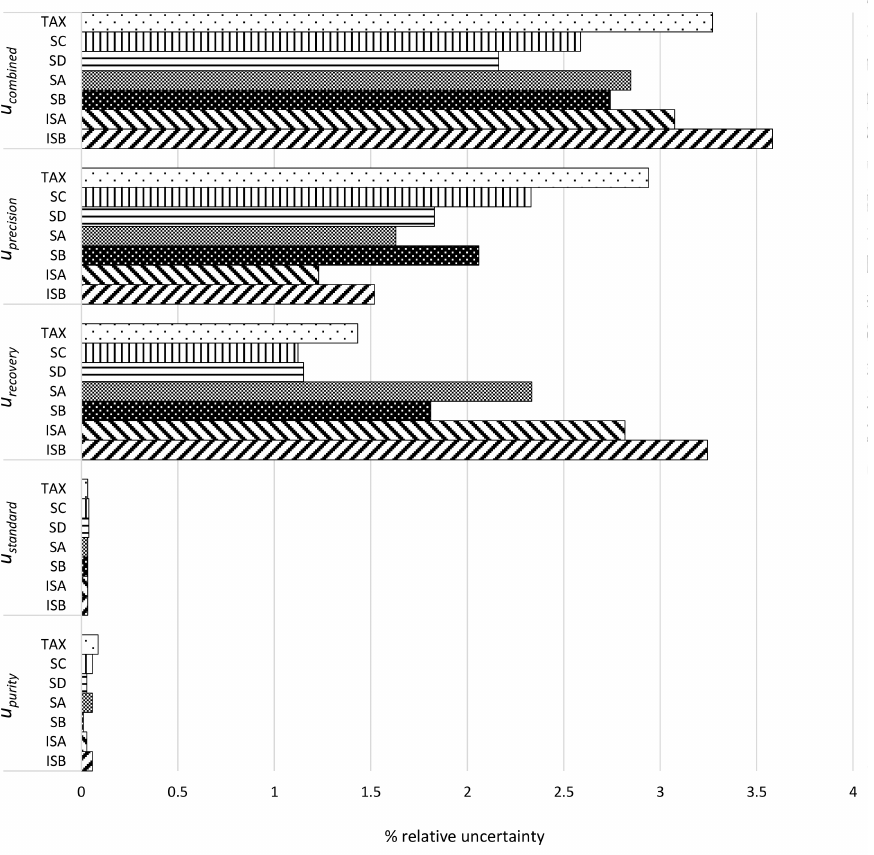
Figure 3. Uncertainty histogram showing the distribution of individual uncertainty component and combined expressed as percentage of taxifolin, silychristin, silydianin, silybin A, silybin B, isosilybin A, and isosilybin B in S. marianum preparation or